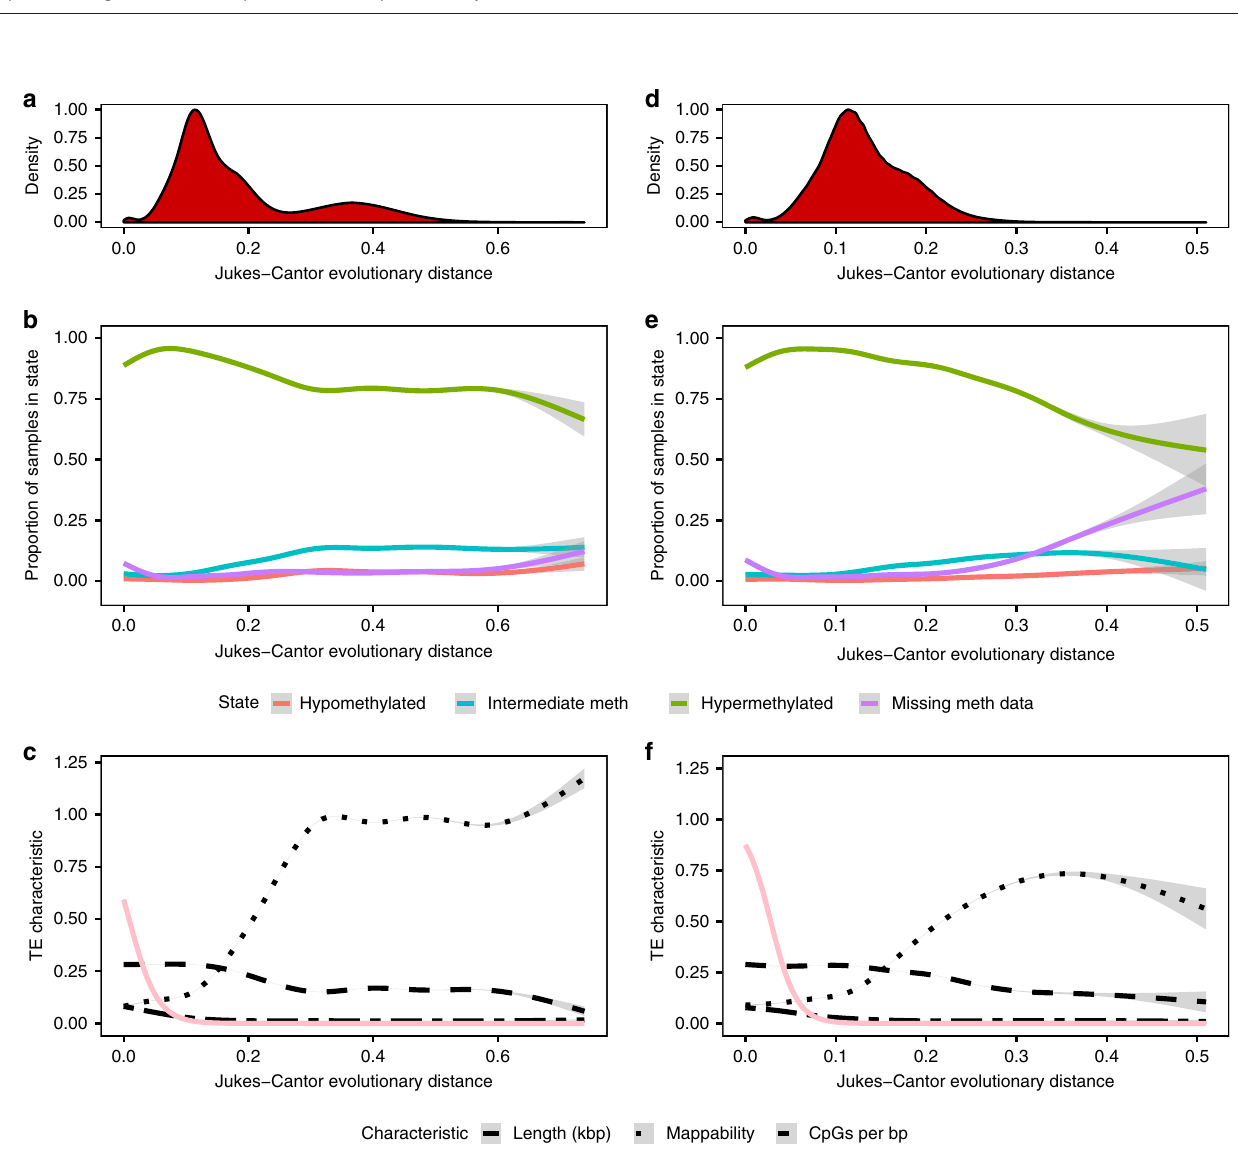
Fig. 5 Tissue-speci fi c enrichment of TE subfamilies in epigenetic states. a The total number of epigenetic states with which each TE subfamily is annotated across all epigenomes (see Methods; n = 968 TE subfamilies, n = 965 for methylation states). b PCA on Roadmap epigenomes ( n = 127 epigenomes), using the LOR enrichment of each TE subfamily in each chromHMM state (13,716 subfamily-by-state combinations) as variables. Color is based on group (see legend above Fig. 5b), and shape is based on epigenome age (non-fetal and unknown age are not distinguished). c PCA on TE subfamilies ( n = 937 subfamilies), using the LOR enrichment of the subfamily in each chromHMM state in each Roadmap epigenome (1,904 state-by- epigenome combinations) as variables. Color is based on class (see legend below Fig. 5d), and shape is based on TE family (only Alu and L1 are highlighted). b , c The amount of variation explained by each PC is listed in parentheses. d The proportion of epigenomes each TE subfamily is enriched LOR > 1.5 in the epigenetic state (chromHMM states 127 epigenomes, methylation states 37, DHS 53, H3K27ac 98). Each subfamily is represented by a circle and is colored by TE class (see Methods). The n below each state on the y -axis indicates the number of subfamilies enriched in the state in at least one epigenome. e The percentage of LTR22A elements that contain a binding motif for the transcription factor. Active TEs: elements annotated with the 7_Enh enhancer state in epigenomes where the subfamily is enriched in the state ( n = 103 TEs); Inactive TEs: elements never in the state ( n = 68 TEs). The top 5 most signi fi cant transcription factors as predicted by HOMER are shown (binomial FDR-corrected P -value < 0.0001 for each).